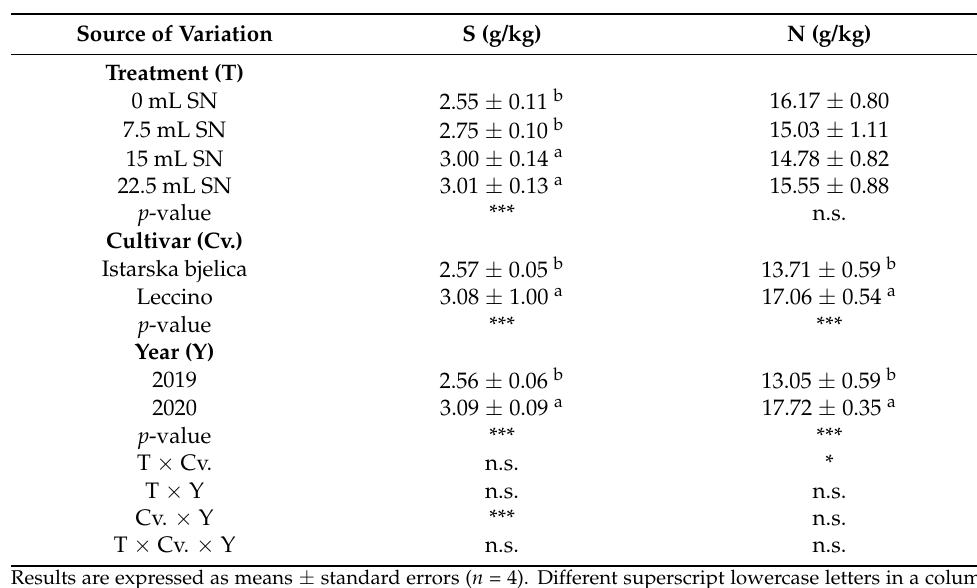
Table 2. The effect of treatment (T) (0, 7.5, 15, and 22.5 mL of applied SN foliar fertilizer per 1 L of water), cultivar (cv.) (Istarska bjelica, Leccino), and collection year (Y) (2019, 2020) on sulfur and nitrogen concentrations in olive leaves.